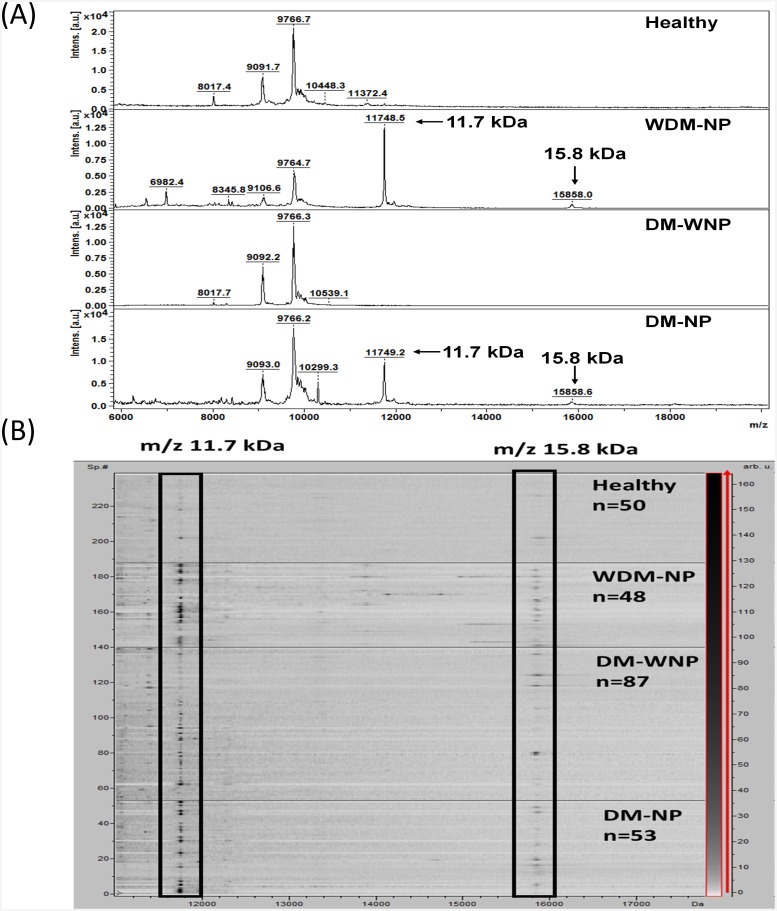
(A) Representative MALDI-TOF mass spectra of urine samples from a healthy individual and patients with WDM-NP, DM-WNP and DM-NP. (B) Pseudo gel view of the urine protein profiles. The horizontal line indicates the separation between the healthy, WDM-NP, DM-WNP, and DM-NP groups. The differential density along the x-axis represents the abundance of specific protein in the samples.